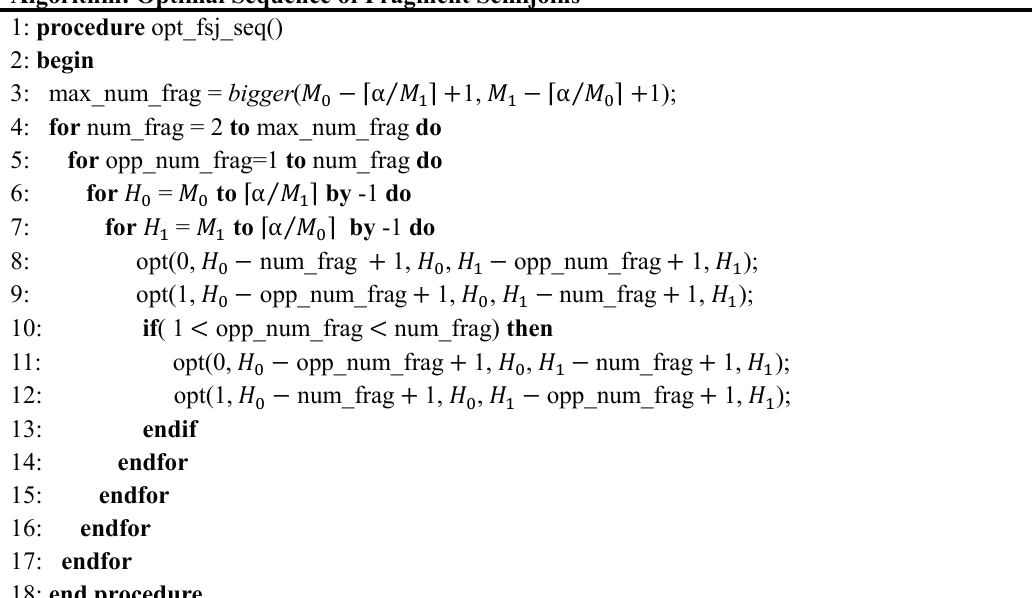
Algorithm: Optimal Sequence of Fragment Semijoins